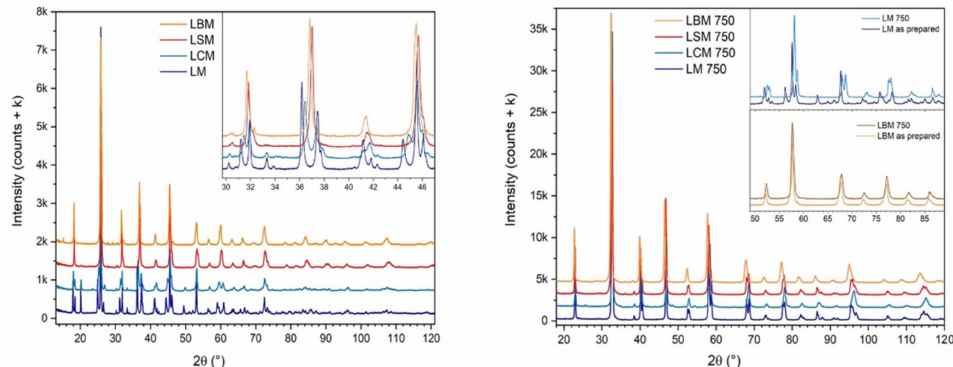
Figure 1. Conventional X-ray powder diffractograms of the LM, LCM, LSM and LBM as-prepared manganites and the LM750, LCM750, LSM750 and LBM750 calcined samples. Note that symmetry differences in the as-prepared samples are evidenced by the different number and positions of diffraction peaks, especially for LM and LCM, while all calcined samples show the same number of peaks as expected for the presence of rhombohedral phases (see respective insets).